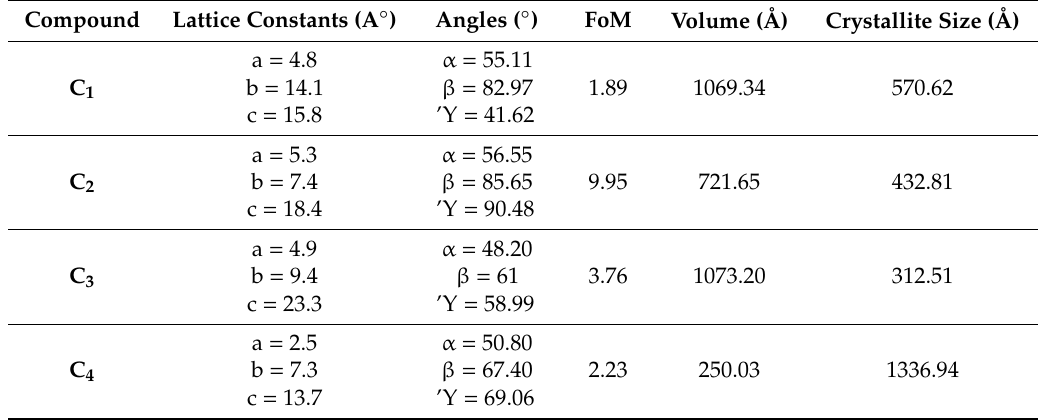
Table 1. Unit cell parameters, volume, and crystallite size of metal complexes. FoM, figure of